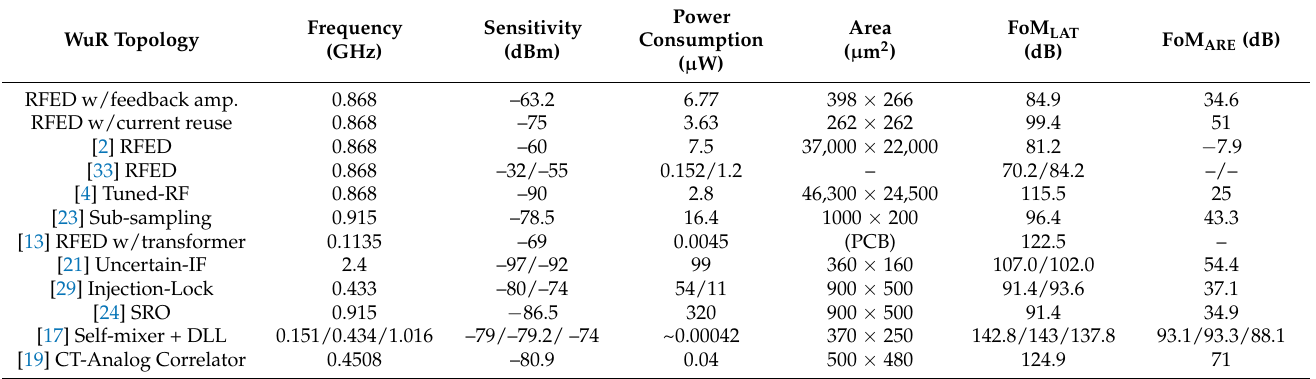
Table 3. Performance summary of the explored RFED-based solutions.